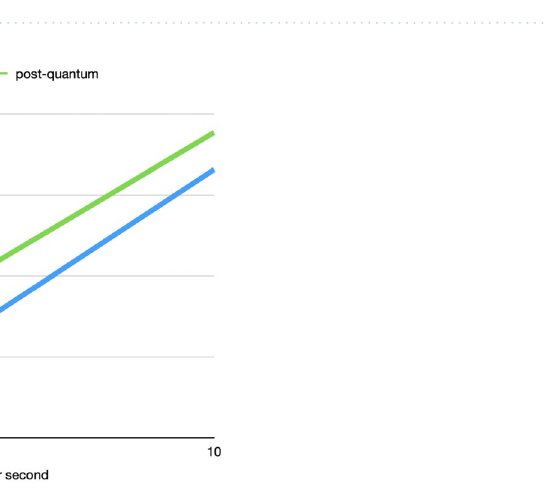
Figure 15. Comparison between the use of CPU in the classical and post-quantum scenarios when sending 5 tx/s.